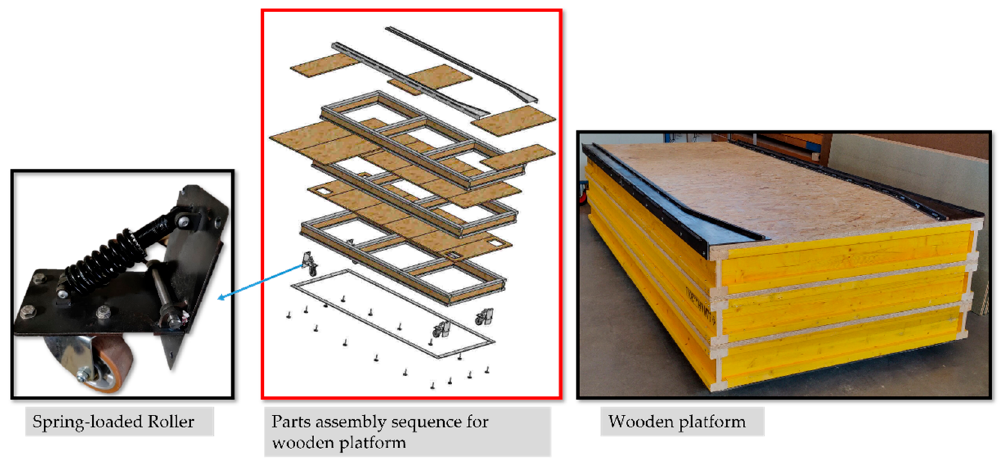
Figure 4. Wooden platform components and assembly sequence.